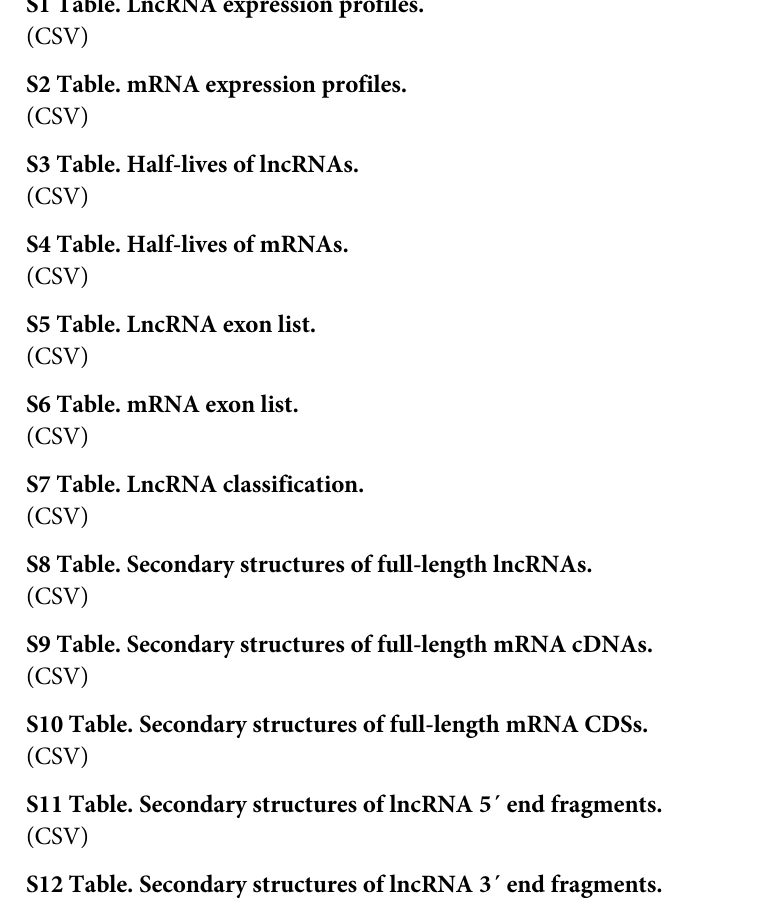
S1 Table. LncRNA expression profiles. S2 Table. mRNA expression profiles. S3 Table. Half-lives of lncRNAs. S4 Table. Half-lives of mRNAs. S5 Table. LncRNA exon list. S6 Table. mRNA exon list. S7 Table. LncRNA classification. S8 Table. Secondary structures of full-length lncRNAs. S9 Table. Secondary structures of full-length mRNA cDNAs. S10 Table. Secondary structures of full-length mRNA CDSs. S11 Table. Secondary structures of lncRNA 5´ end fragments. S12 Table. Secondary structures of lncRNA 3´ end fragments. S13 Table. Secondary structures of mRNA 5´UTR fragments. S14 Table. Secondary structures of mRNA 3´UTR fragments. S15 Table. LncRNA expression profiles in nucleus and cytoplasm. S16 Table. mRNA expression profiles in the nucleus and the cytoplasm. S17 Table. Half-lives of nucleus-specific lncRNA. S18 Table. Half-lives of nucleus-specific mRNAs. S19 Table. Half-lives of cytoplasm-specific